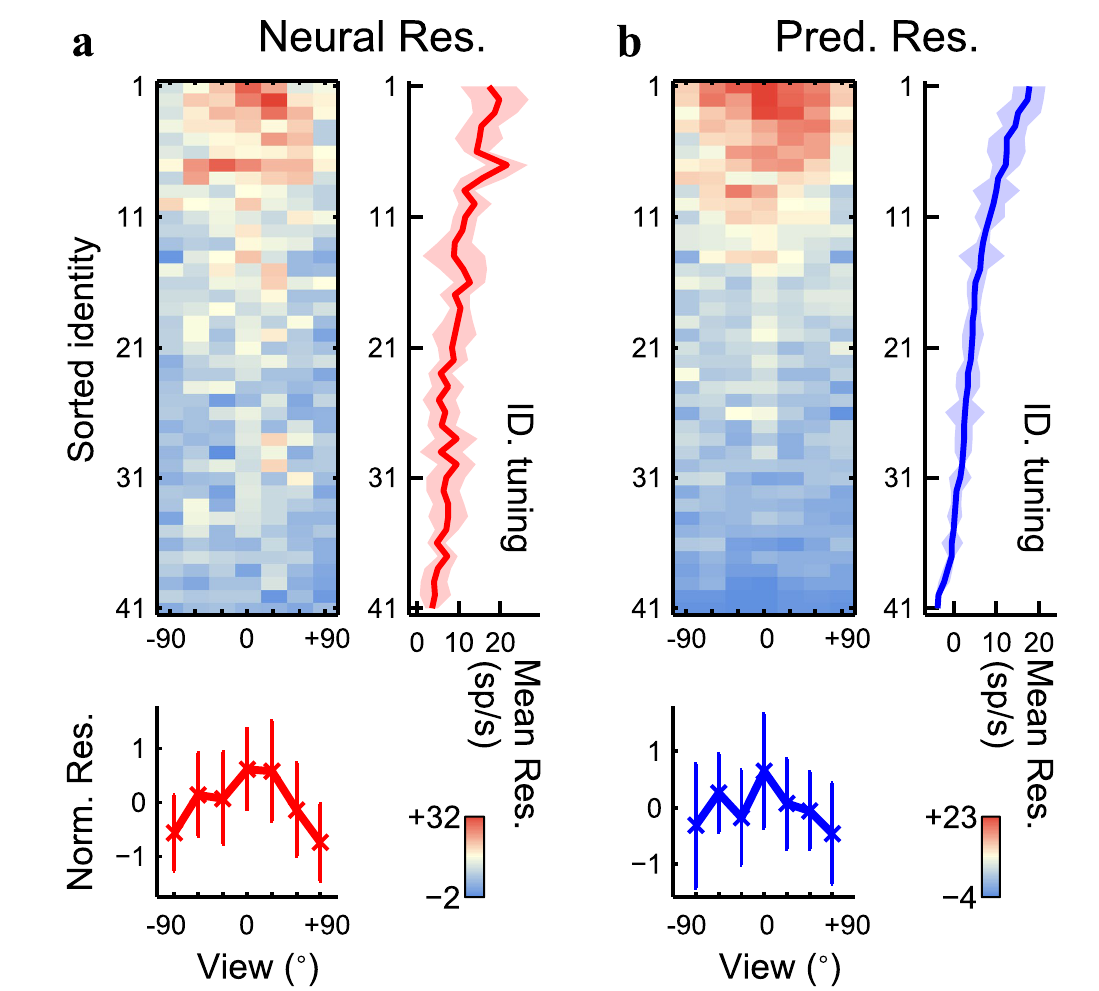
Figure 6. ( A ) The neural responses of 287 view-controlled face stimuli recorded from site S1_a. The vertical axis, 41 identities in descending order of the predicted responses. The horizontal axis, 7 views from left (− 90) to right (+ 90) profiles taken by every 30°. ( B ) The predicted responses generated from the feature candidate shown in Fig. 3A. In both panels, the trace in the right side indicates the identity tuning curve obtained by averaging across views, and the trace at the bottom indicates the view tuning curve obtained by averaging responses normalized with the z-score (see “Methods”). The shades and error bars indicate the standard